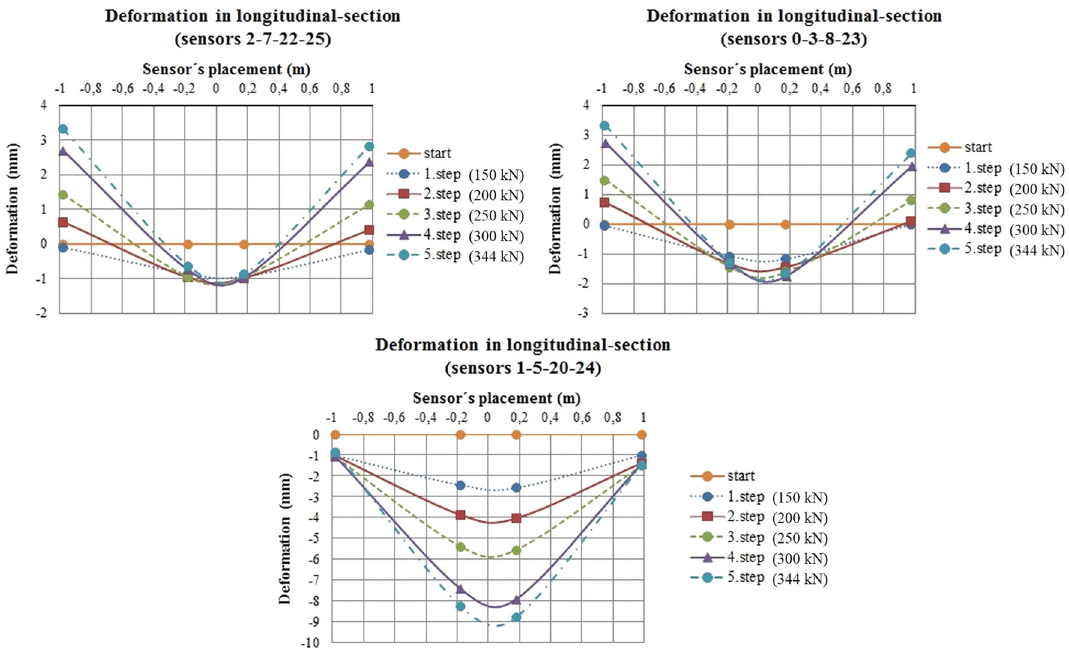
Fig. 6 Vertical deformation of the slab—in longitudinal-sections